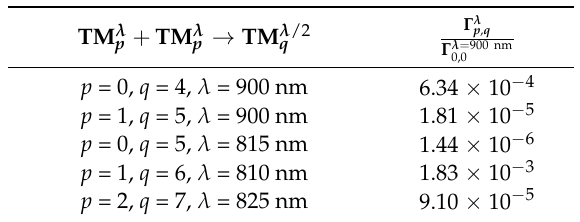
Table 1. Comparison of different values of overlap integrals Γ λ p , q , where λ is the pump wavelength. The calculations shown are for possible modal-dispersion phase matching (MDPM) interactions indicated in Figure